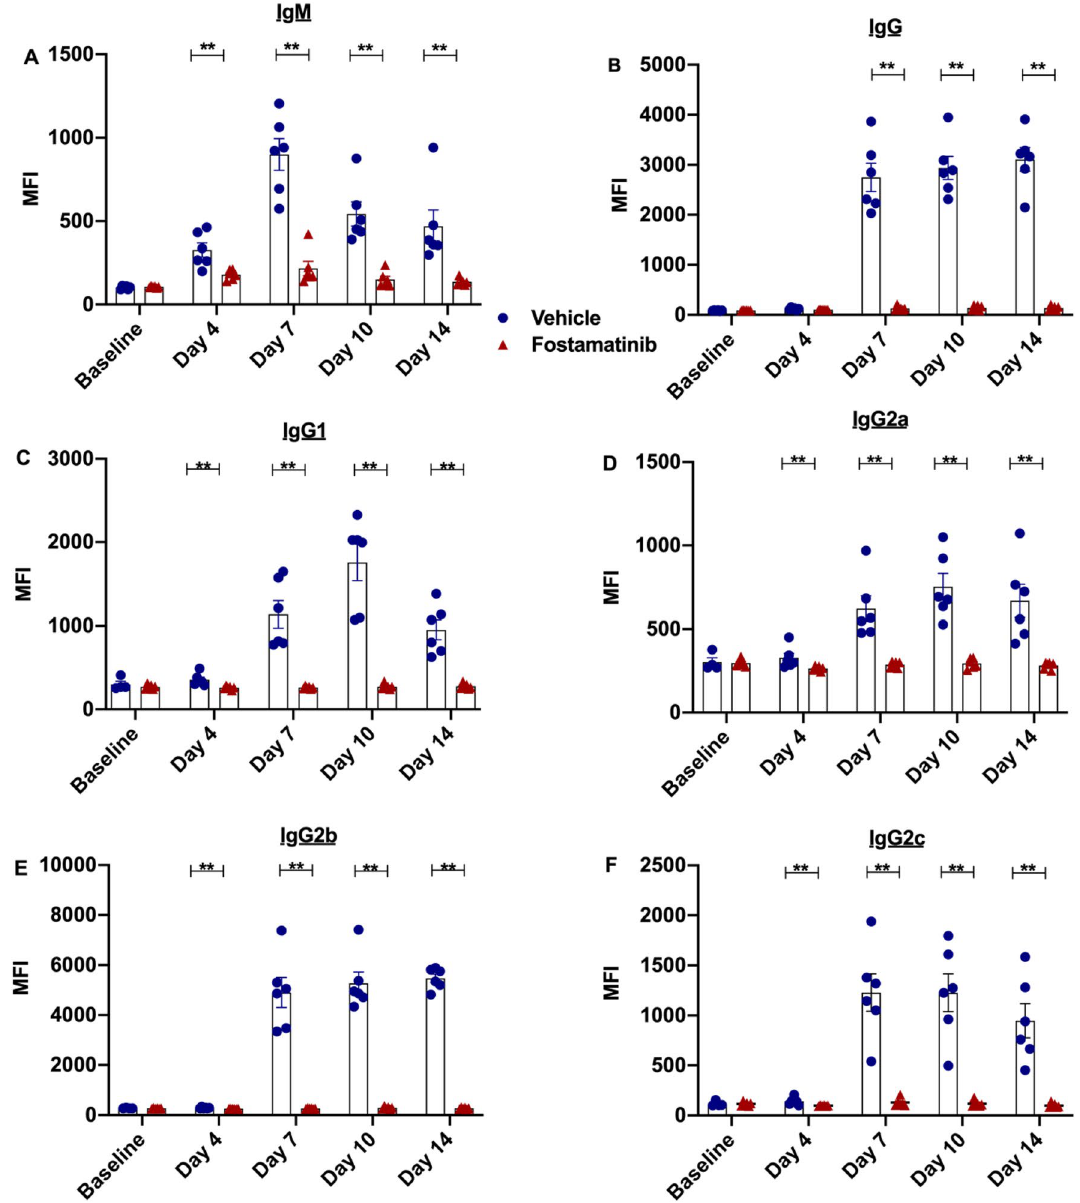
Figure 2. Fostamatinib treatment prevented production of donor specific antibody. T Lymphocyte crossmatch was performed to detect DSA levels in sensitized fostamatinib treated and vehicle treated LEW rats. ( A ) IgM, ( B ) IgG and ( C–F ) IgG subset production was inhibited by fostamatinib treatment at all time points measured (n = 6 rats/group). *P ≤ 0.05, **P ≤ 0.01. Blue Filled circle—vehicle, red filled